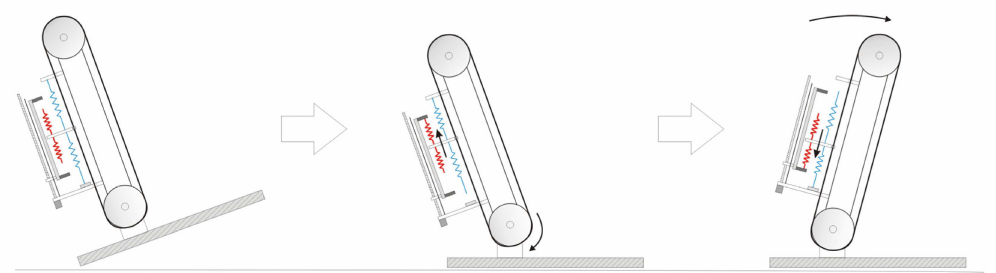
Figure 12. Process of a passive step using BIASAT